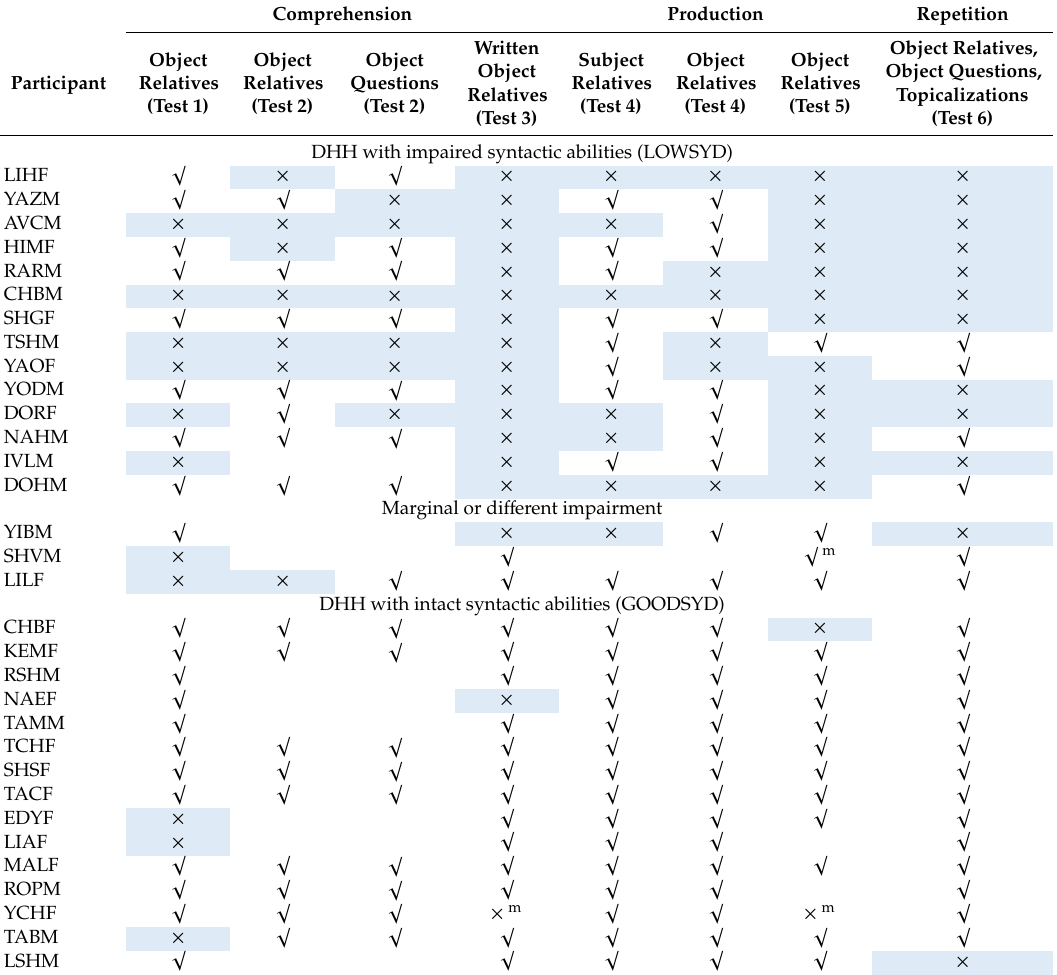
√ —not di ff erent from hearing